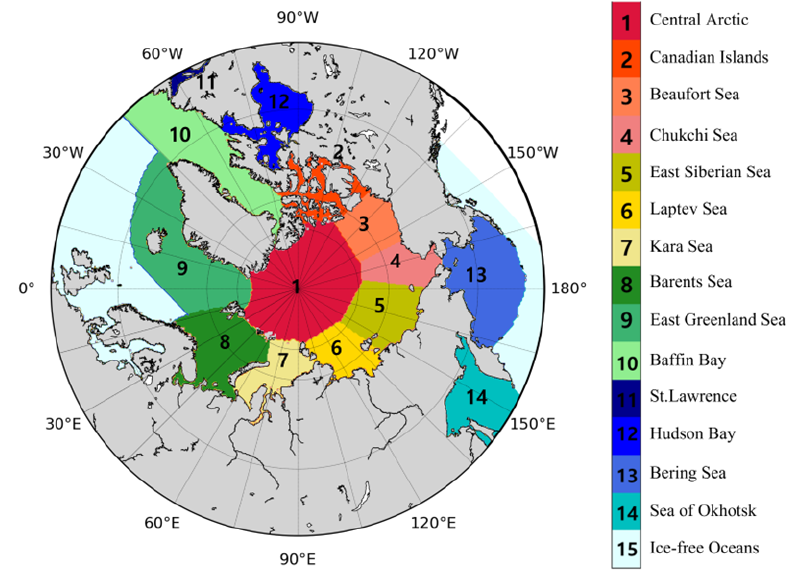
Figure 1. Location map in the Arctic regions.